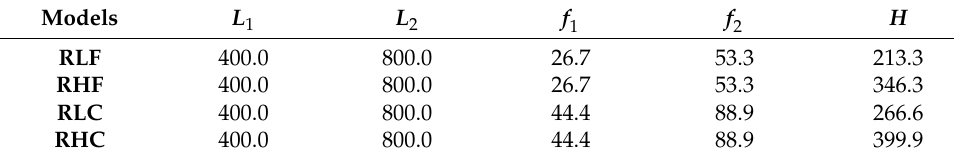
Figure 1. Experimental setup: ( a ) RLF; ( b ) RHF; ( c ) RLC; ( d ) RHC (acronyms as in [30]). Table 1. Test model geometrical parameters, measurements in